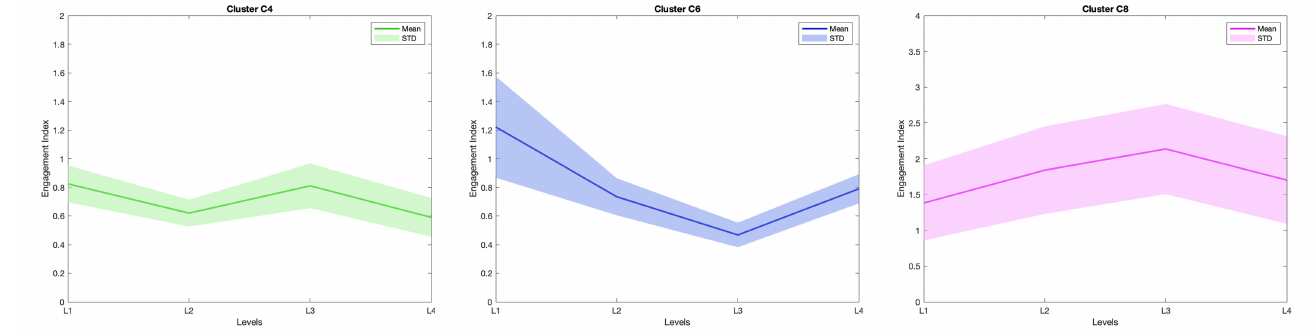
Figure 11. Engagement Index (EI) across the four levels, in the three most populated